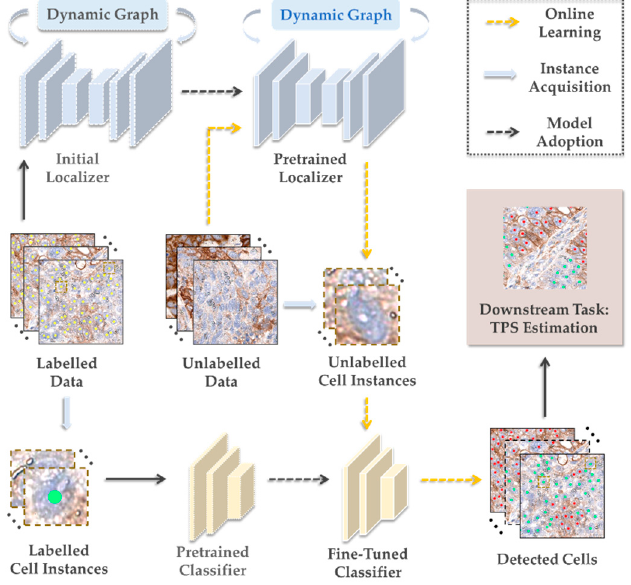
Figure 2. GeoNet pipeline.